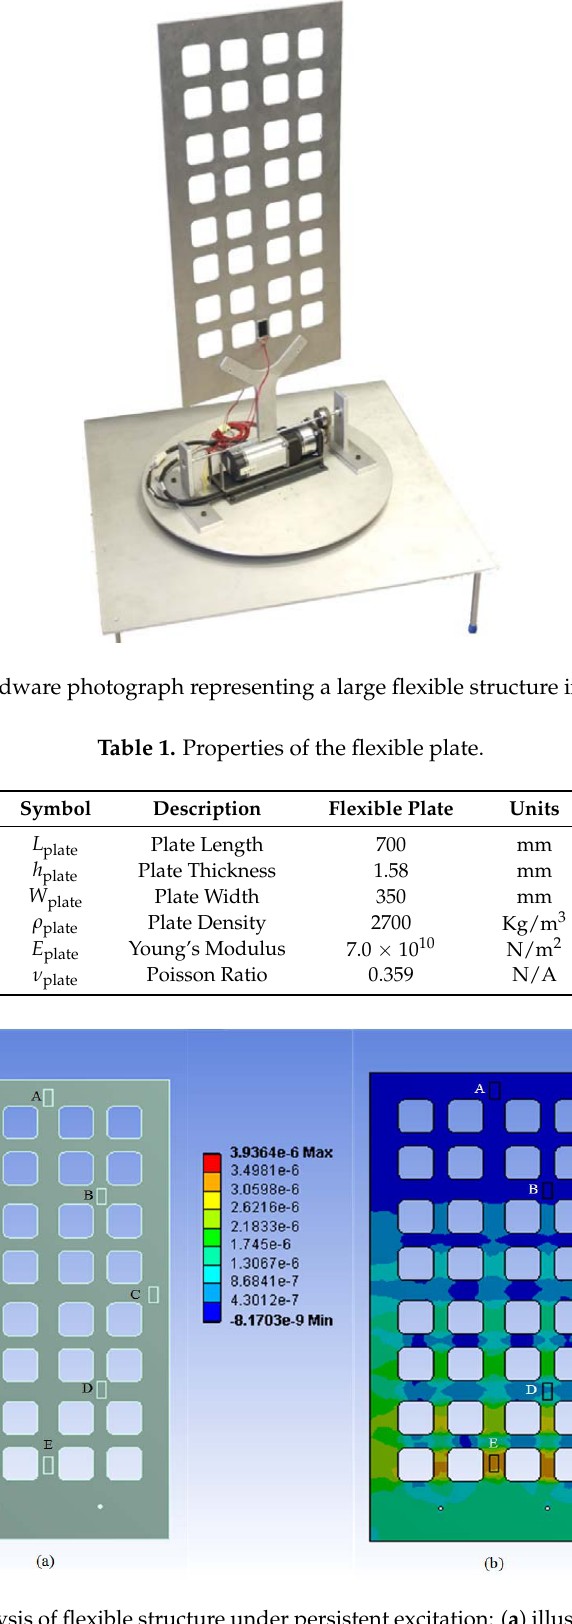
Figure 8. Modal analysis of flexible structure under persistent excitation: ( a ) illustration of the structure used for modal analysis; and ( b ) strain distribution throughout entire structure. Capital letters refer to the five locations used in evaluating the placement of piezoelectric sensors.